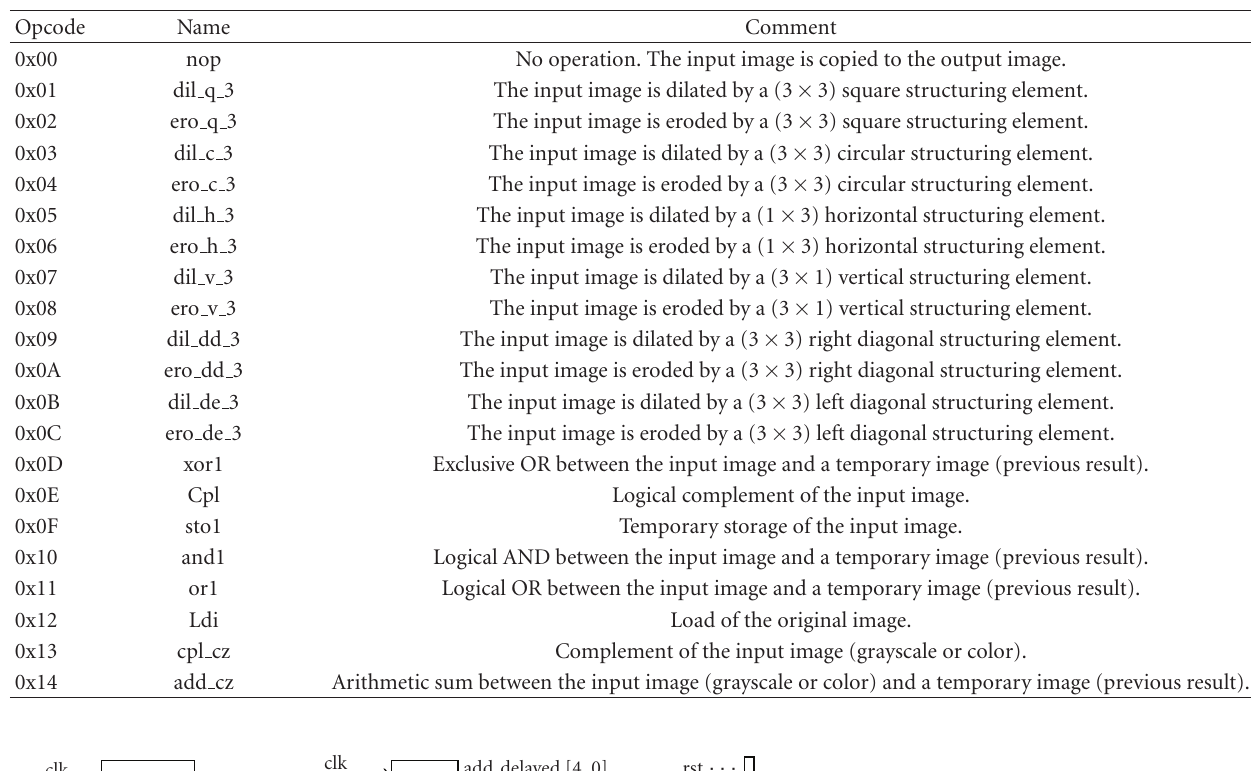
Figure 5: Block diagram of the pipeline stages. Table 1: Implemented instructions.